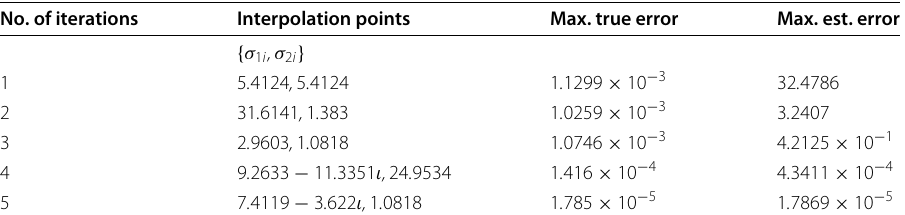
Fig. 2 Non-linear RC circuit Table 2 Error estimation results for Burgers’ equation No. of iterations Interpolation points